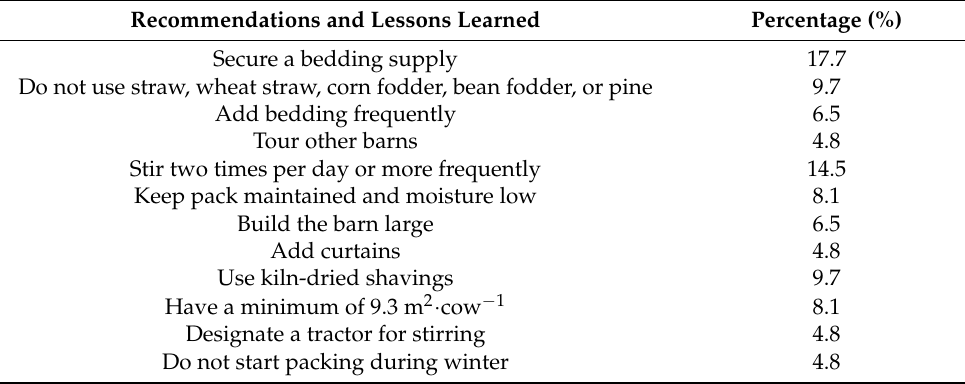
Table 3. Producer recommendations and lessons learned by CBP barn producers.